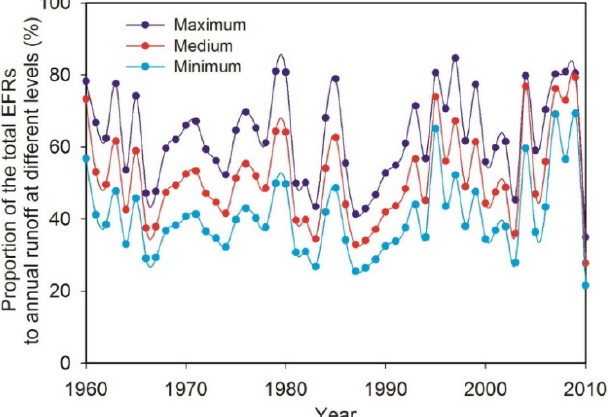
Figure 7. Proportion of the total EFRs to annual runoff at different levels (Maximum, Medium, and Minimum) in Qira oasis.